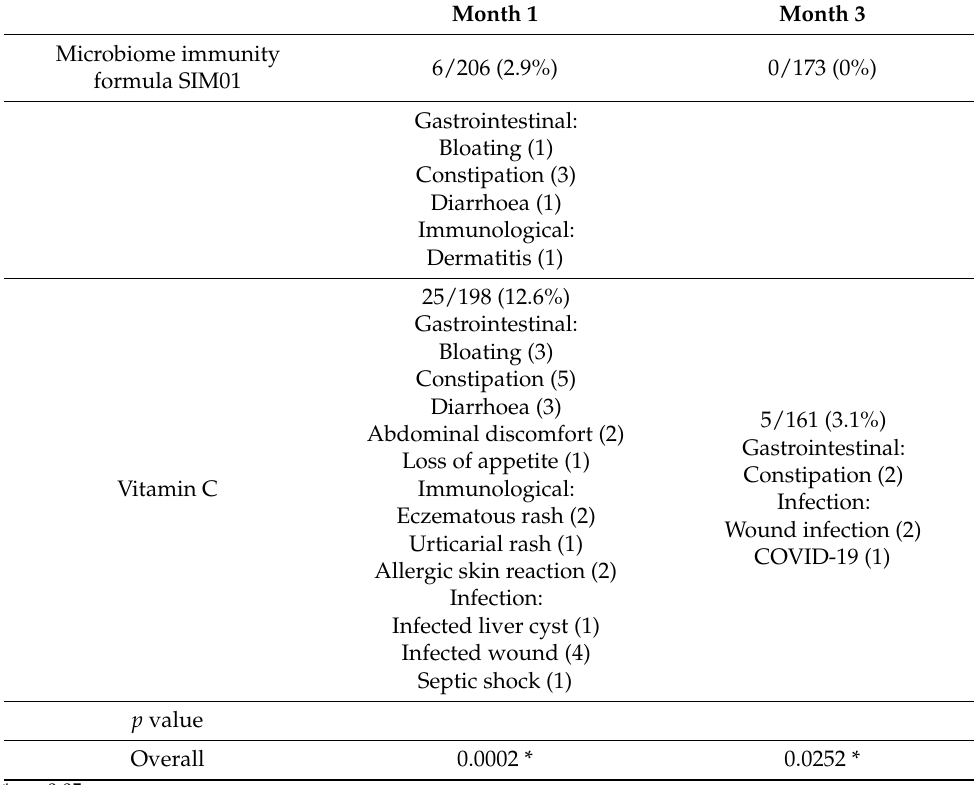
Table 2. The incidence of adverse health outcomes at 1 month and 3